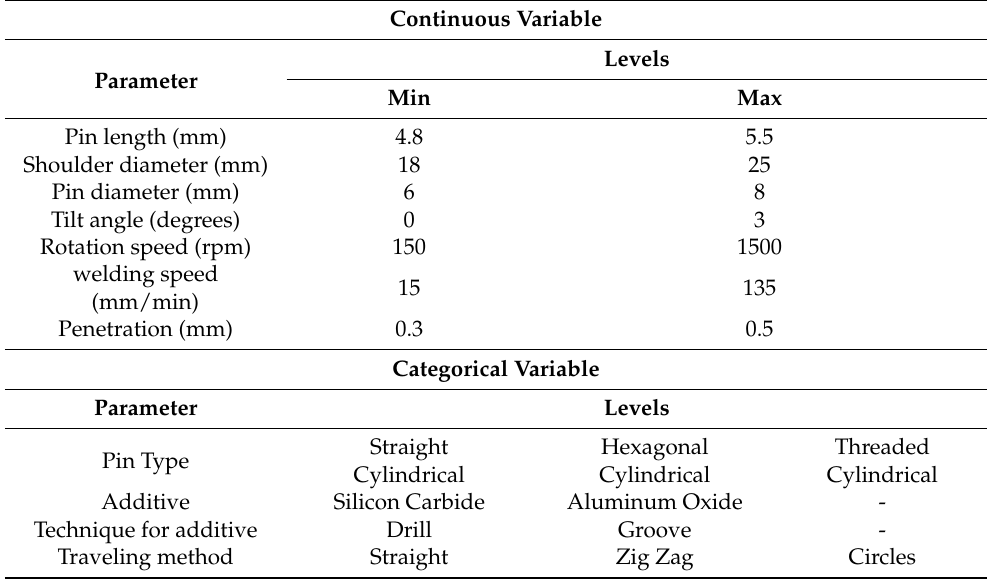
Table 3. Input parameters of FSW.